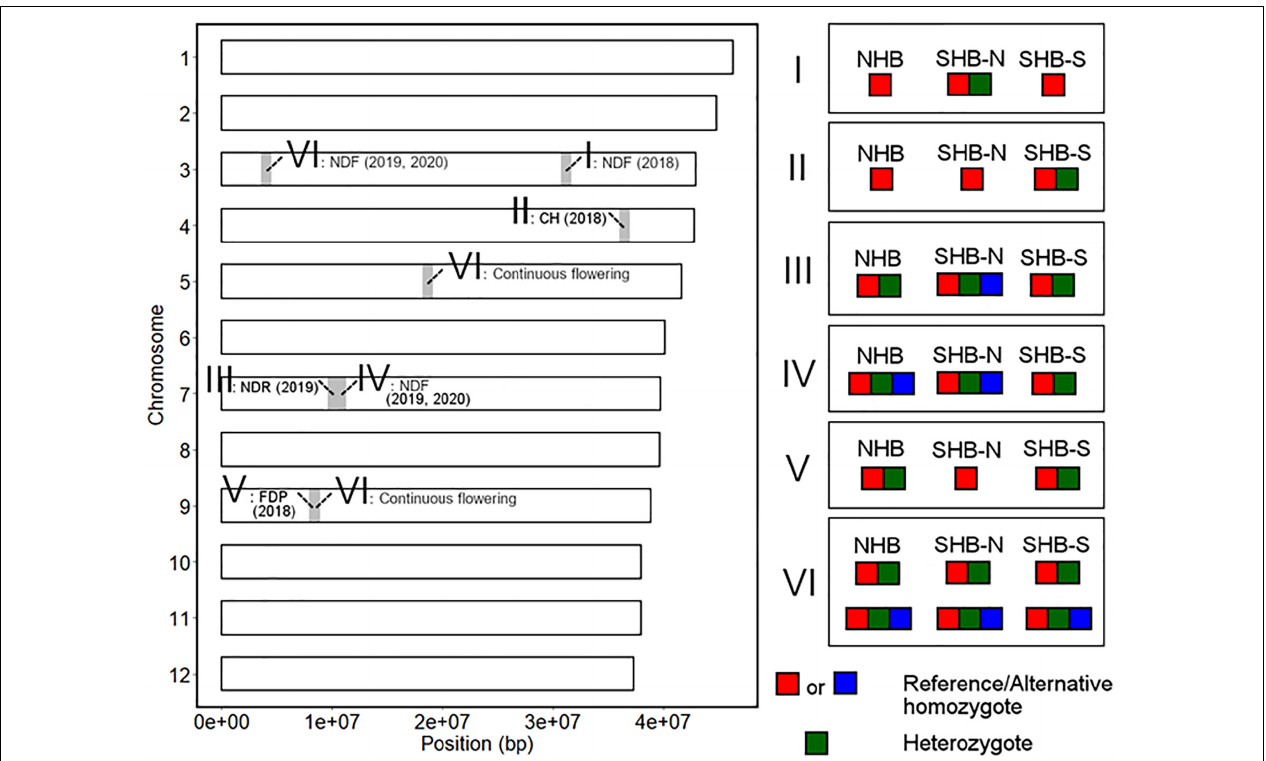
FIGURE 10 | Summary of the genotype patterns of the phenology-associated loci in the highbush population. The left figure represents the chromosomal position of the detected loci. The significant loci were classified according to the genotype pattern in the highbush population as shown in the right figure. SHB-N and SHB-S represent SHB from southern and northern breeding locations,